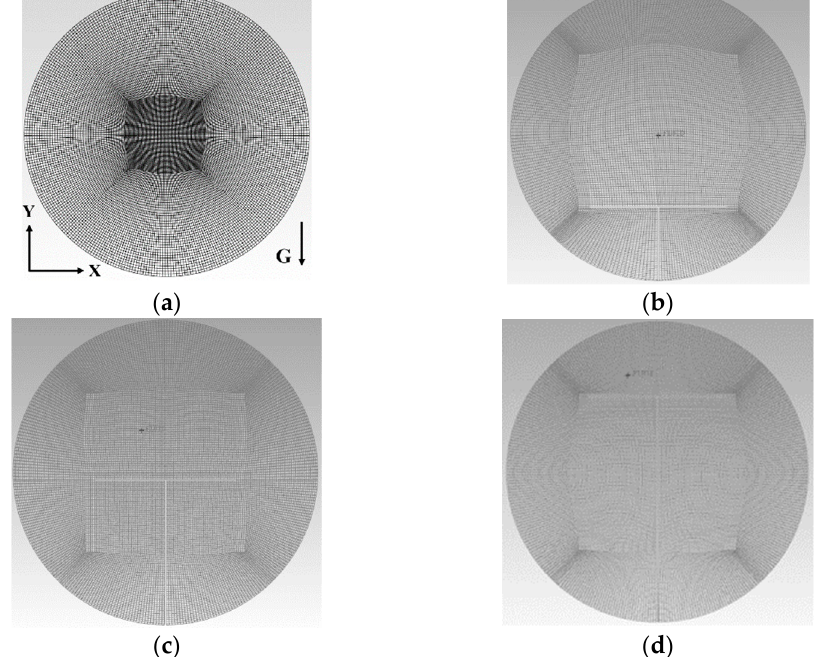
Figure 2. Grid schematic diagrams. ( a ) non-baffle; ( b ) baffle with HR = 0.25; ( c ) baffle with HR = 0.50; ( d ) baffle with HR = 0.75.